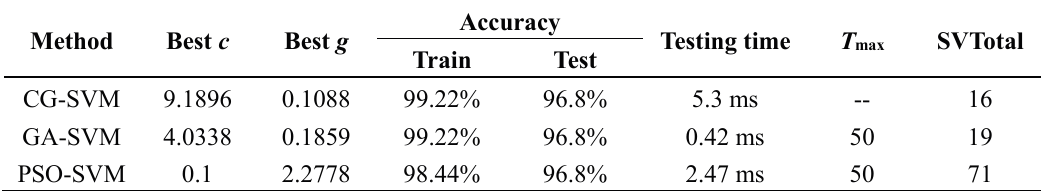
Table 3. Comparison with different parameter search